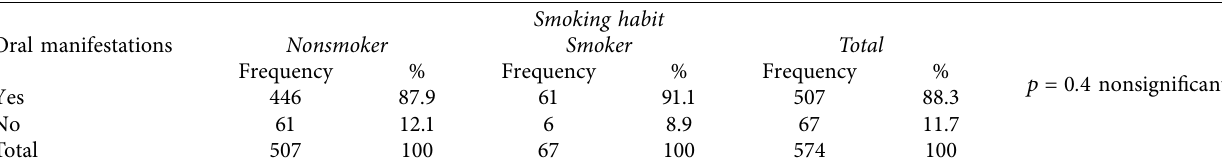
Table 4: Frequency, percentage, and the statistical diference of occurrence of oral symptoms in COVID-19 patients according to the smoking status.